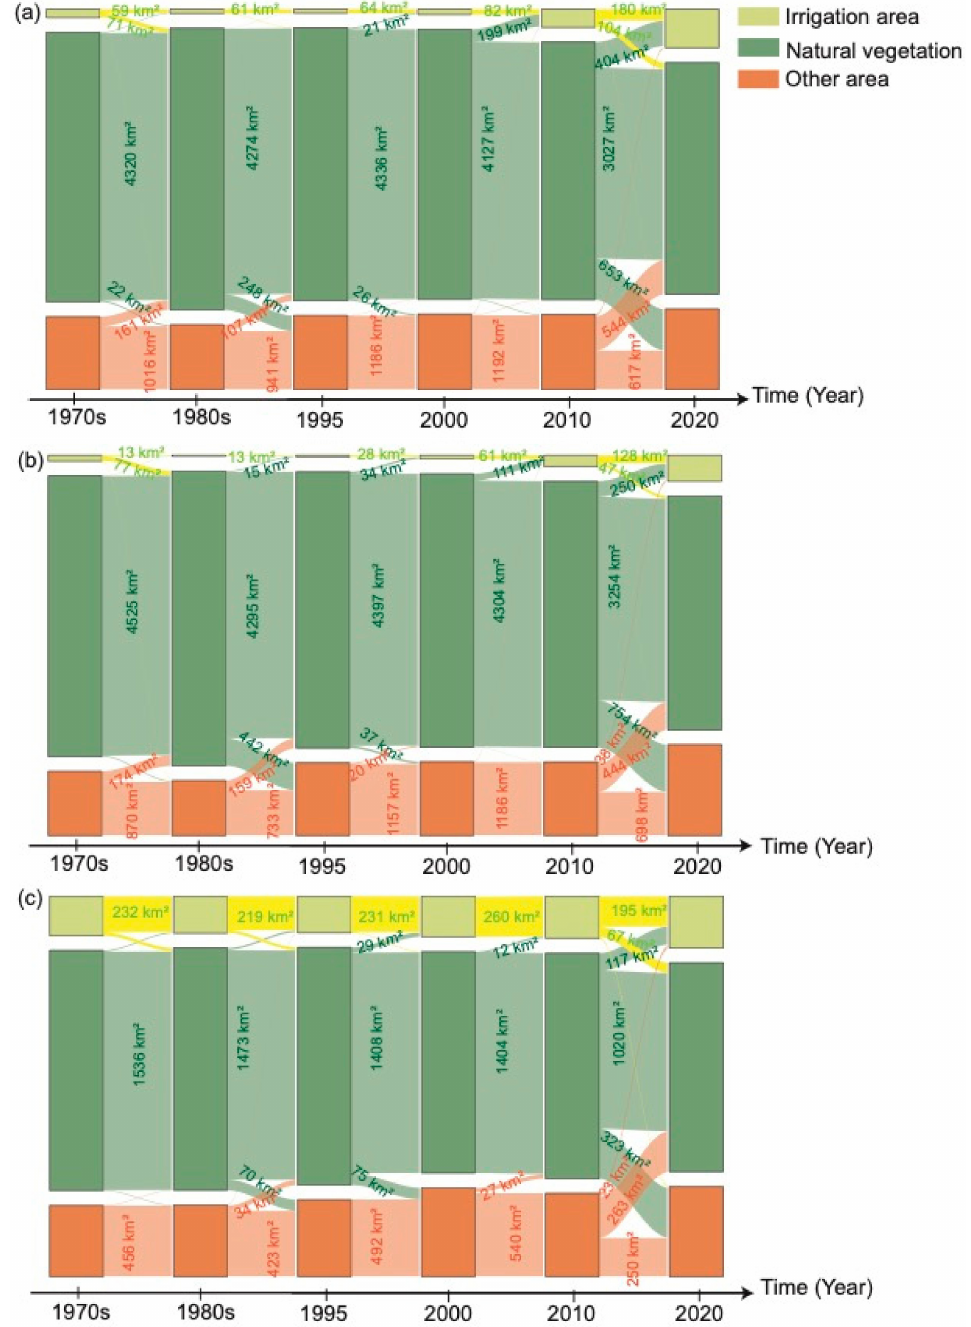
Figure 5. Transition matrix of land use and land cover changes from 1970 to 2020 in the ( a ) upstream, ( b ) midstream, and ( c ) downstream of the Tarim River Basin. This diagram shows how the area is transformed before becoming farmland, natural vegetation, or other areas; supplies are on the left, and demands are on the right, where the width of each flow pictured is based on its